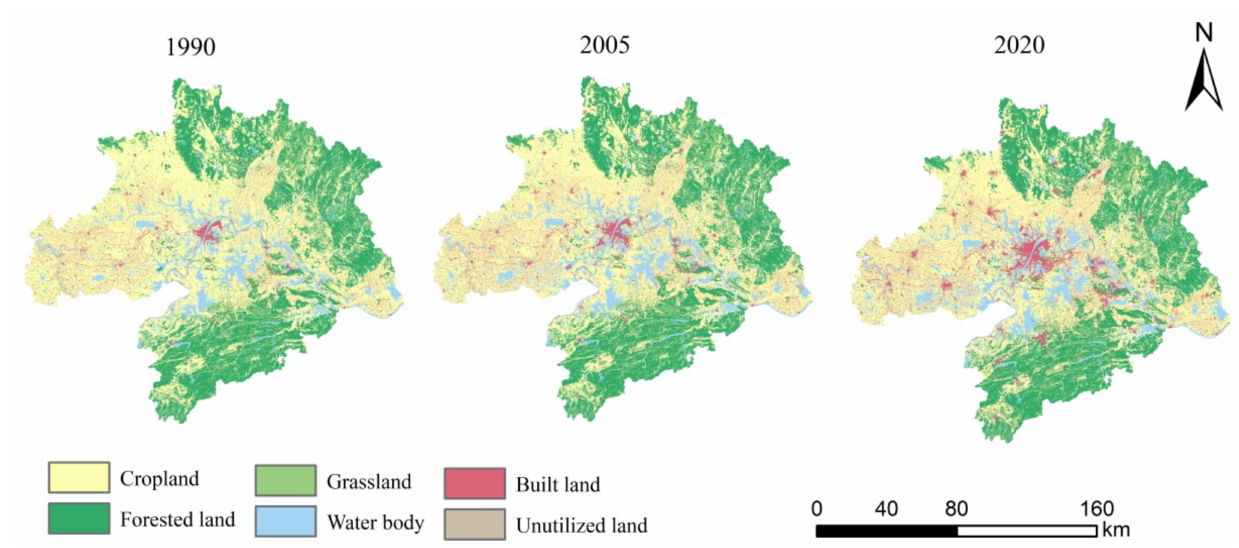
Figure 2. Evolution of land-use in the Wuhan metropolitan area from 1990 to 2020.